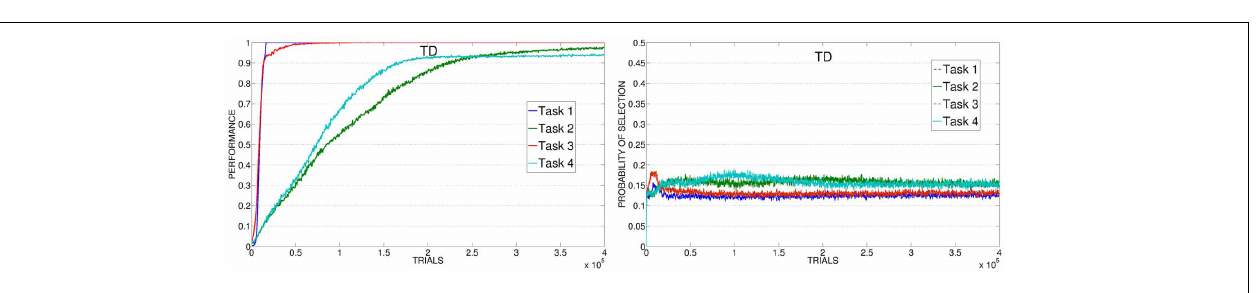
FIGURE 14 | Average performance and selections in TD